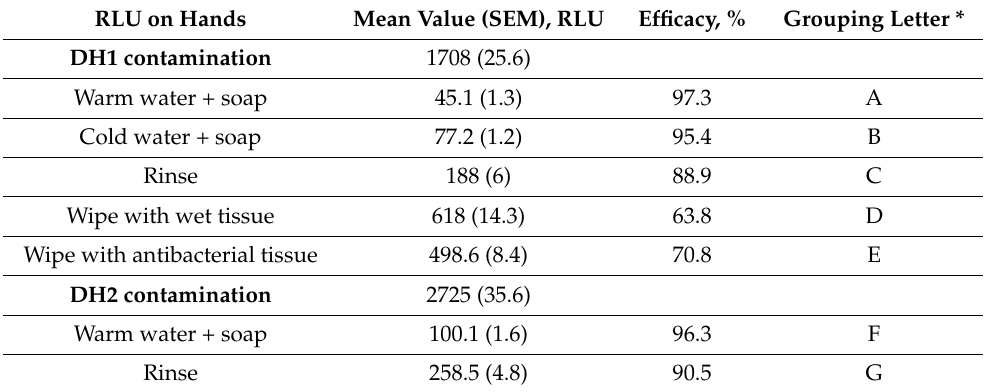
Table 2. Efficacy of the tested hand-cleaning procedures on DH1 and DH2 scenarios. RLU on Hands Mean Value (SEM), RLU Efficacy, % Grouping Letter * DH1 contamination 1708 (25.6) Warm water + soap 45.1 (1.3)